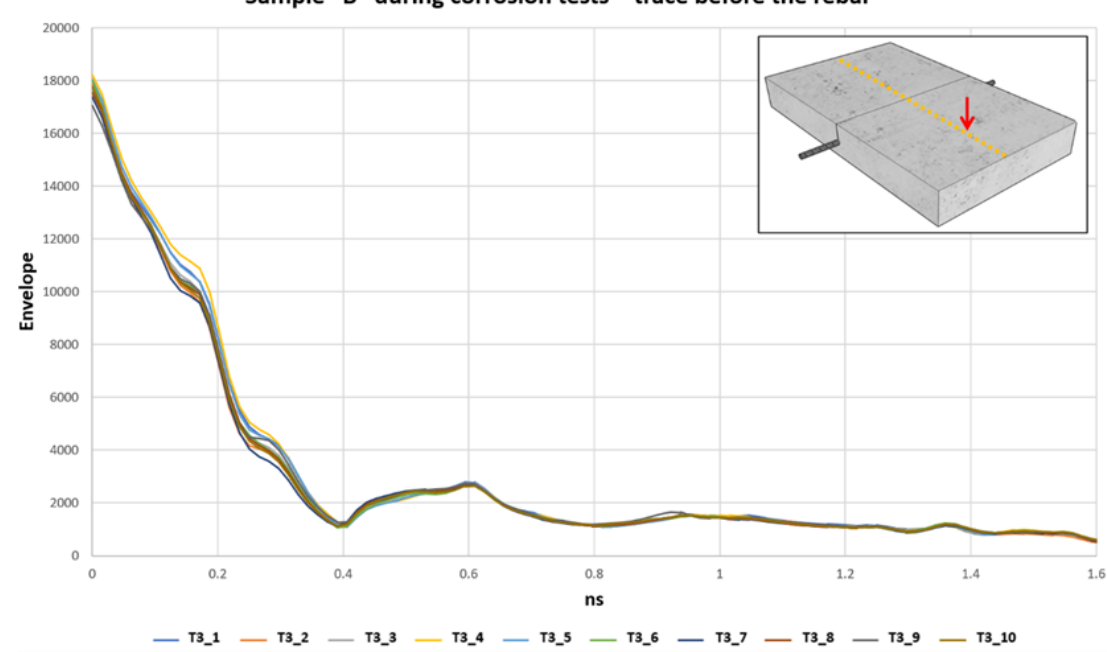
Figure 11. Envelope A-scan was acquired on sample “B” during the accelerated corrosion test. The trace shown is taken from radargram n°29, at 10 cm after steel rebar, inside the concrete sample. From the graph, we can see that there were no changes in the envelope A-scan trace during the corrosion test.